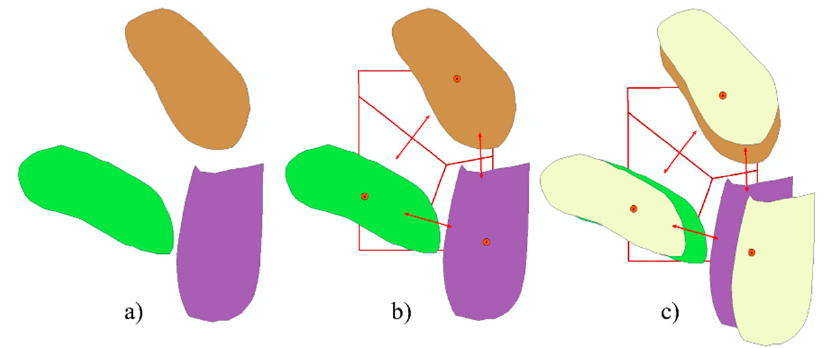
Figure 8. Voronoi-based algorithm. ( a ) Original polygons. ( b ) Generation of Voronoi polygons used to propagate displacement. ( c ) An overlay of the original and displaced polygons. Figure 9 features two examples of the application of the Voronoi-based displacement algorithm with both the original and displaced polygon positions shown.